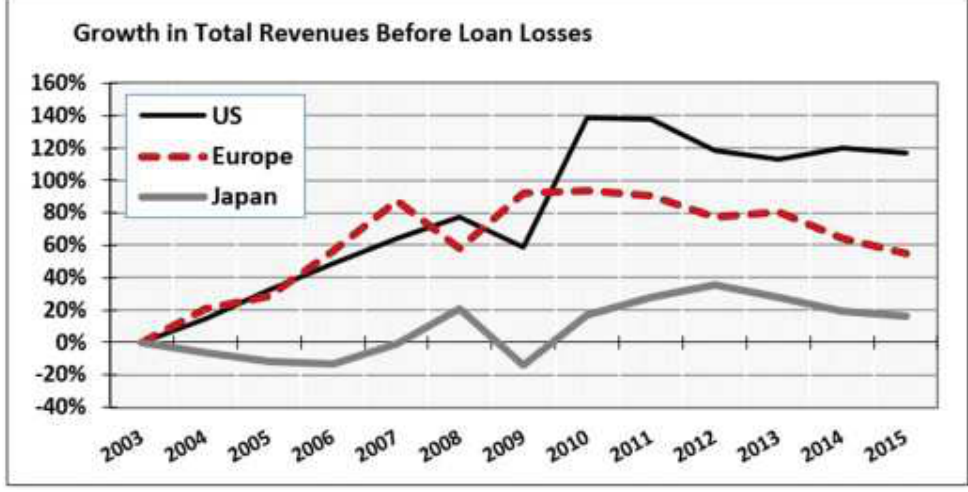
Fig. 2. Growth in Total Revenues Before Loan Losses for U.S., European and Japanese Banks,